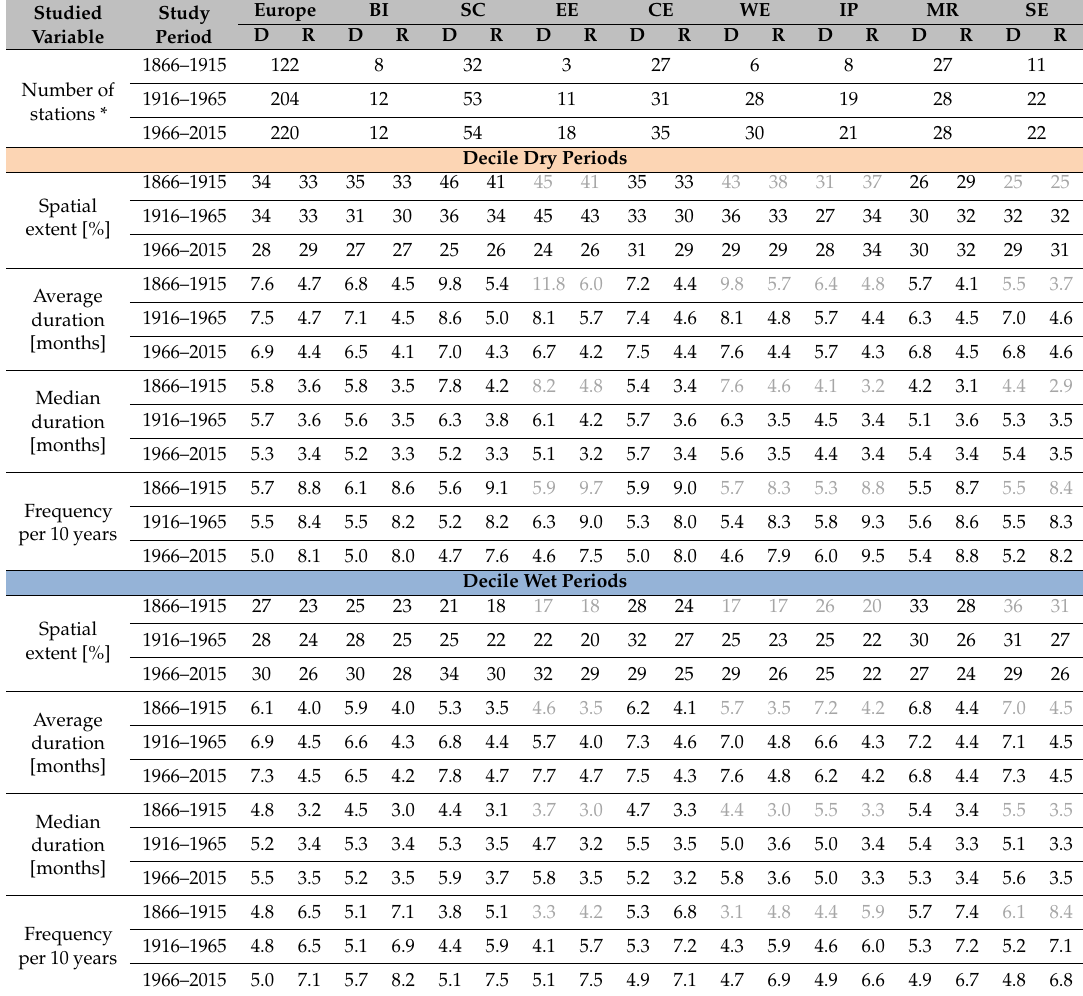
Table 2. Displayed are characteristics of dry and wet periods (spatial extent, duration, and frequency) for Europe and the eight sub-regions (for the region abbreviations BI, CE, EE, IP, MR, SC, SE, and WE please refer to Figure 1) comparing three 50-year periods (1866–1915, 1916–1965, and 1966–2015). Two di ff erent dry and wet period definitions are used: D for decile periods and R for the mRAI periods. The first rows show the number of the stations per regions with a data availability above 50% in the respective study period. Results for periods with low data availability ( ≤ 50% of the stations are available) are printed in light